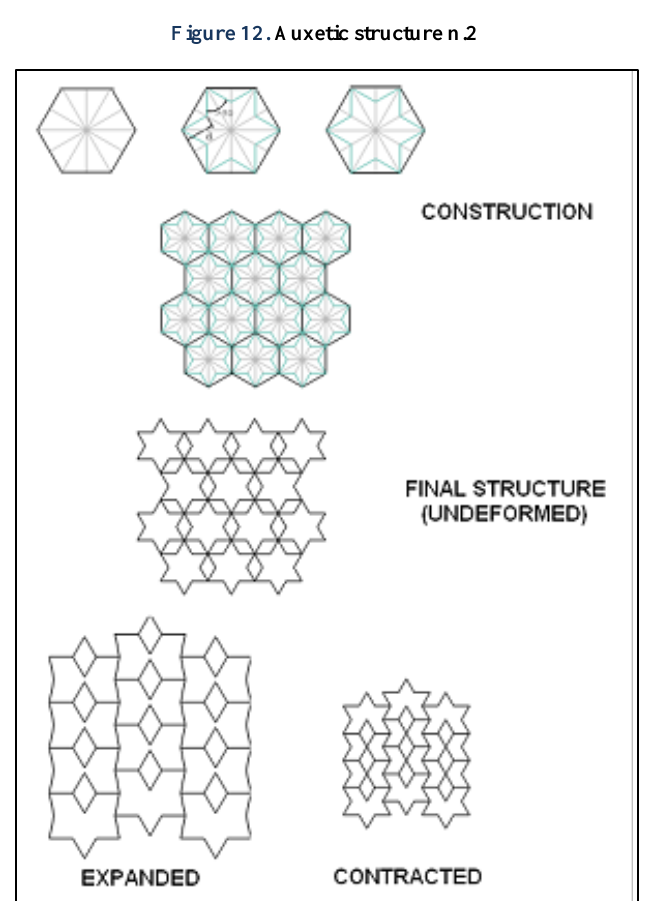
Figure 13. Auxetic structure